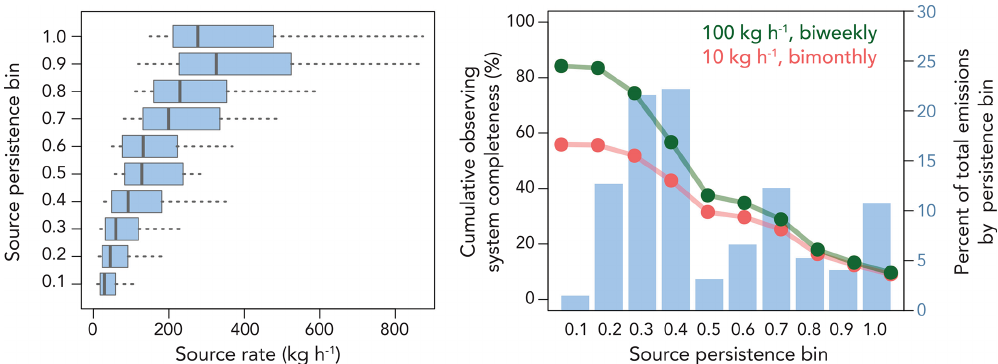
Figure 8. Point source rates, persistence, and observing system completeness for an ensemble of 2500 oil and gas point sources sampled by aircraft remote sensing in five US oil and gas basins (Cusworth et al., 2022). The left panel shows the frequency distribution of mean point sources rates for different persistence bins ( p , fraction of the time that the source is detected), where the mean is computed by assuming zero emission when no plume is detected. Boxes and whiskers indicate 10th, 25th, 50th, 75th, and 90th percentiles. The right panel shows the percentage of total point source emissions contributed by different persistence bins. Also shown in that panel is the cumulative observing system completeness C = C D × C S × C T (Eq. 8) for 1 year of observations under 30% clear-sky conditions and two observing systems, one with 100kgh − 1 detection threshold and bi-weekly sampling (green line) and one with 10kgh − 1 and bi-monthly sampling (red line). We assume spatial coverage C S = 0 . 95 for both. The observing system completeness is computed individually for each basin and then averaged. Both observing systems have comparable performance for sources with high persistence ( p > 0 . 5) but the biweekly observing system performs better for sources with low persistence despite its higher detection threshold.